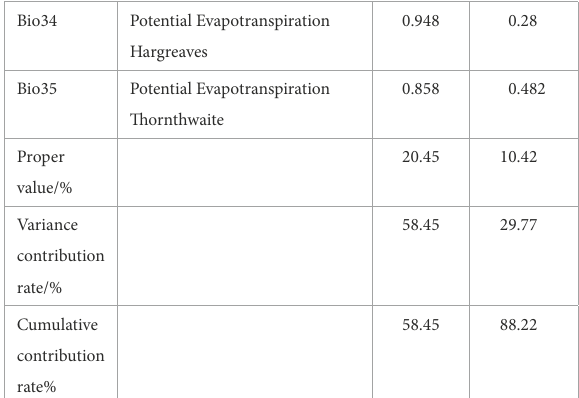
TABLE 1 Principal component analysis of 35 bioclimatic